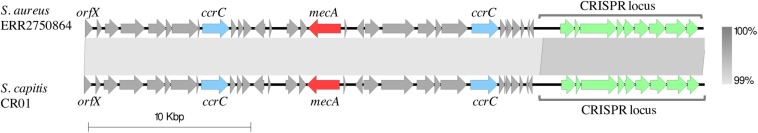
Comparison of the SCCmec-CRISPR structures from a representative of MRSA CC8 clone isolated in Armenia (ERR2750864) and the S. capitis strain CR01 (GenBank accession: LN866849.1). The sequence of the 37 kb SCCmec-CRISPR region from the Armenian MRSA CC8 isolate was aligned against the SCCmec-CRISPR fragment from the S. capitis strain CR01 (coordinates:413424 – 451712). Arrows represent open-reading frames. The following selected genes are annotated: the chromosomal orfX (the 3′-end of this gene represents SCCmec insertion site), ccrC encoding the cassette chromosome recombinase C, mecA encoding the penicillin-binding protein PBP2a that mediates the methicillin resistance and the CRISPR region. Gray blocks between elements indicate regions of shared sequence similarity, shaded to represent the % identity (range: 99–100%). The alignment figure was generated with Easyfig (Sullivan et al., 2011).